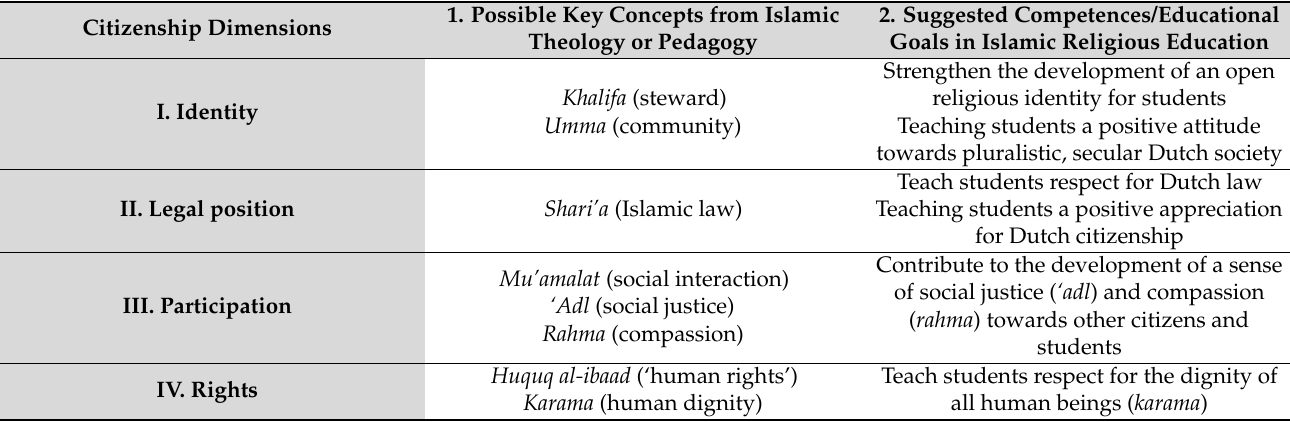
Table 3. Suggestions for key concepts and educational goals to relate CE and